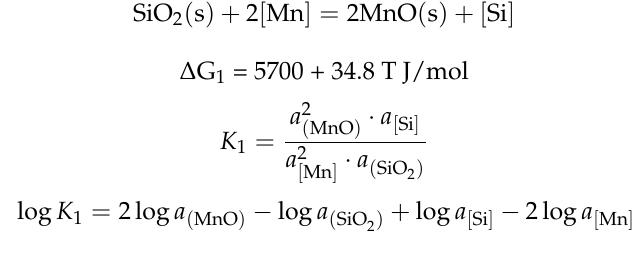
Table 4. Calculated initial chemical composition of steel, mass%. Exp. No.